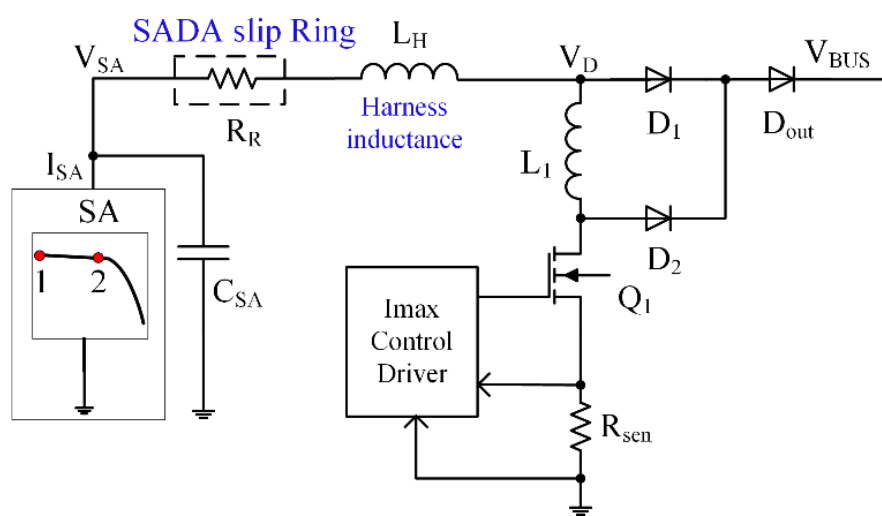
Figure 4. Shunt regulator (SR) topology.